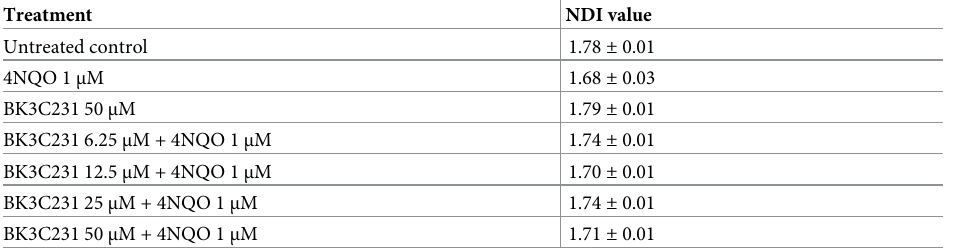
Table 1. NDI values in untreated control cells, BK3C231-treated cells, 4NQO-treated cells and cells pretreated with BK3C231 prior to 4NQO